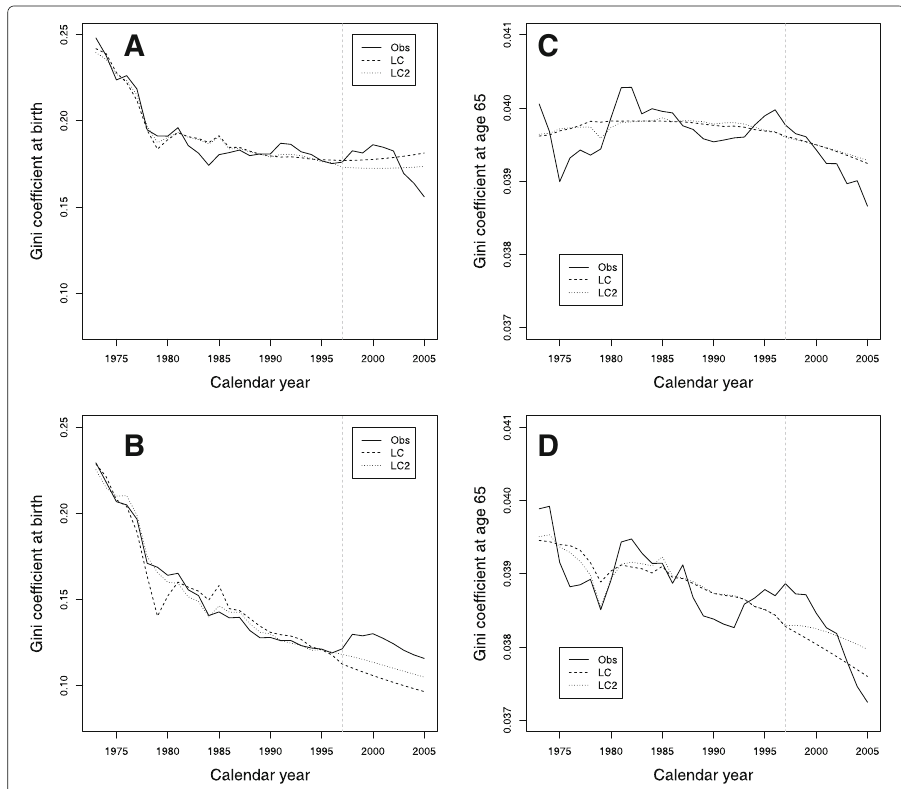
Fig. 3 Comparison of Gini index for the training period 1973–1997 and the validation period 1998–2005. a Gini index at birth for men. b Gini index at birth for women. c Gini index at age 65 for men. d Gini index at age 65 for